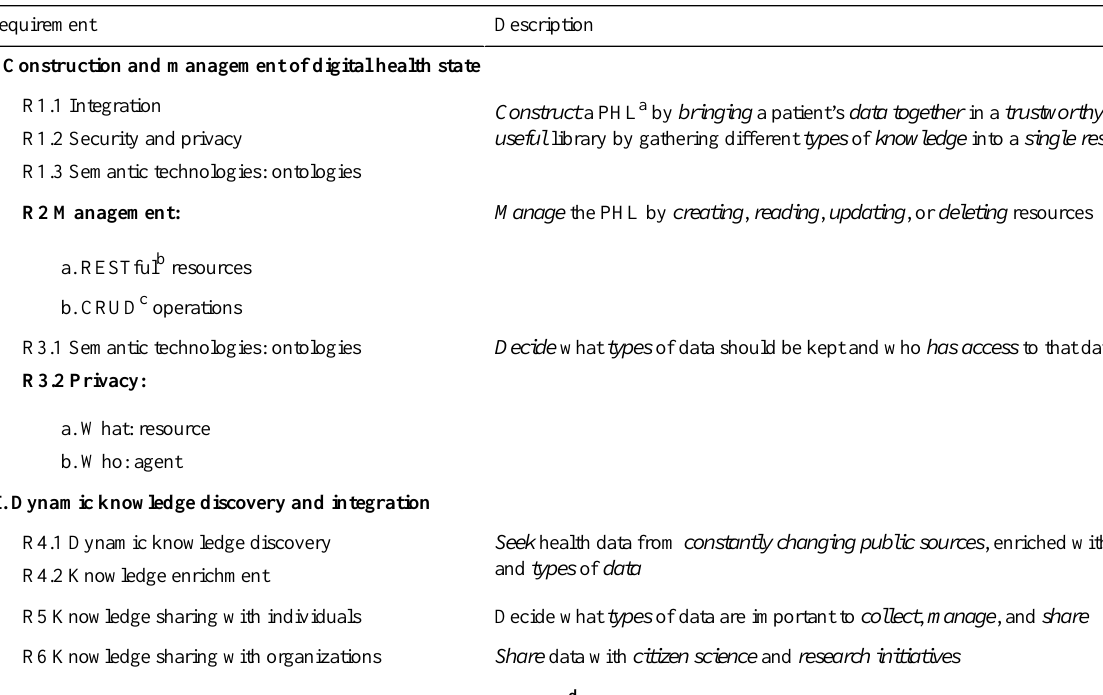
Table 2. Some requirements for a PHL (from a patient perspective, per the